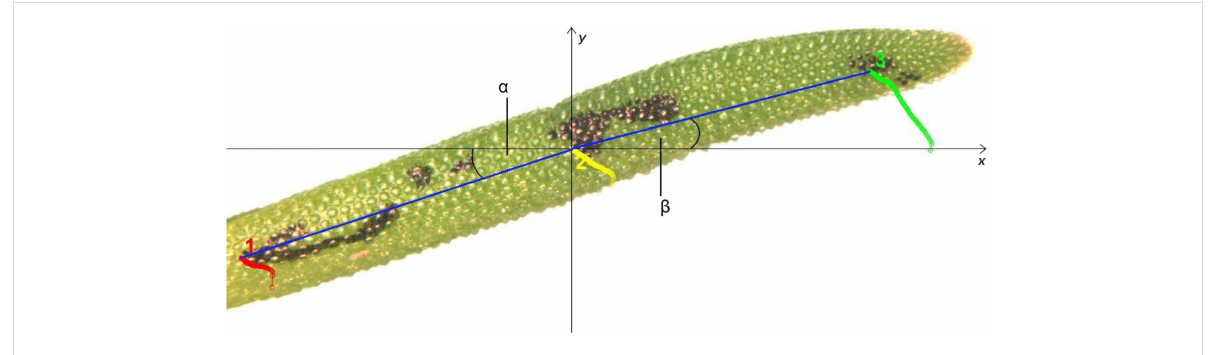
Figure 5: The evaluation of self-sealing. The tracking of three defined points at the leaf base (1), close to the injury (2) and at the leaf tip (3) during the bending of the injured leaf is the basis for calculating the angles α and β . Further calculations lead to the relative bending angle γ , which repre- sents a quantitative measure for the self-sealing movement during a given time